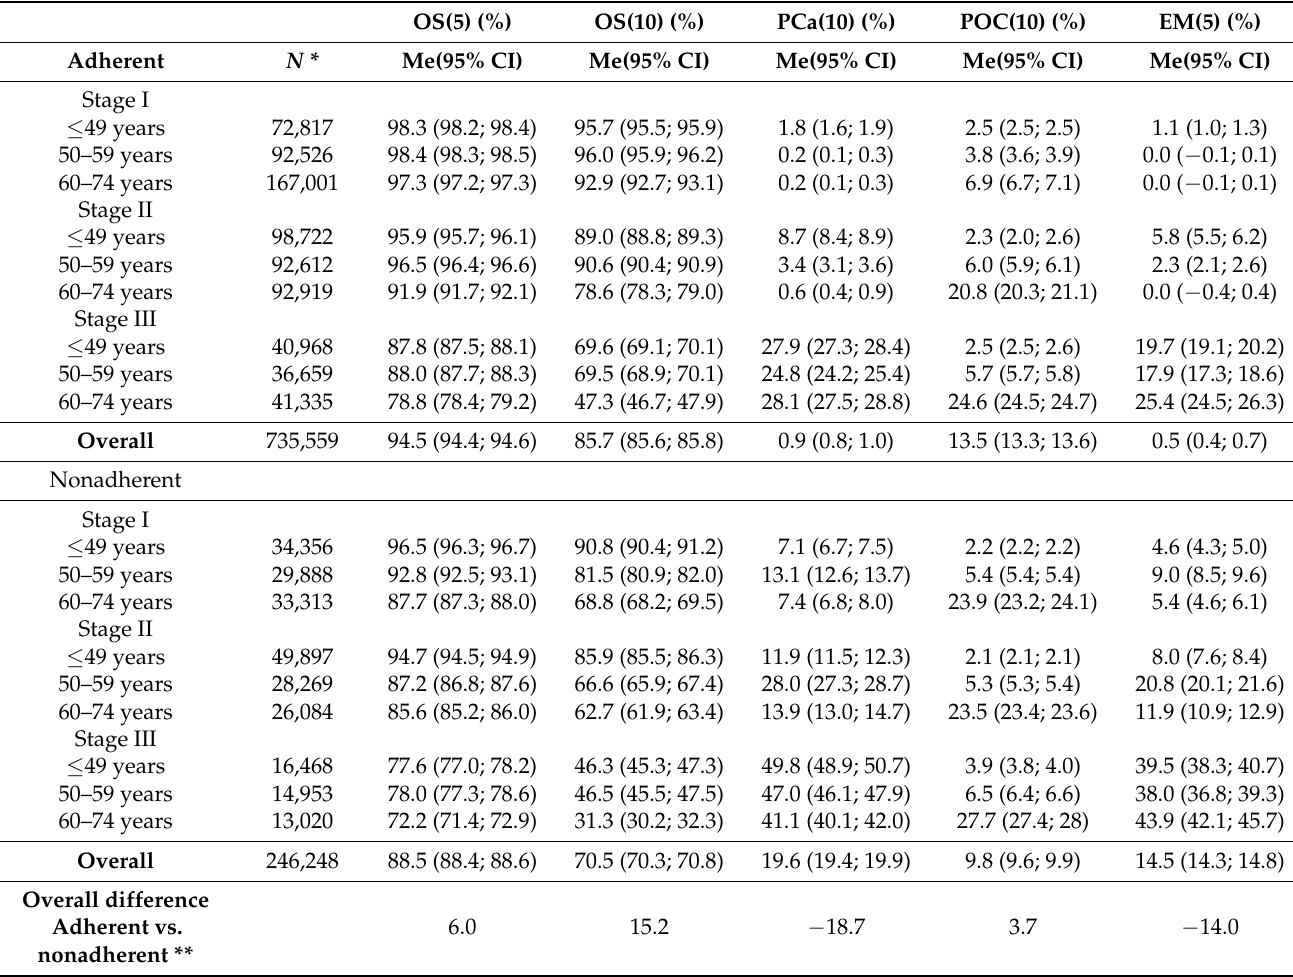
Table 3. Survival indicators derived from synthetic cohort comparing breast cancer patients adherent vs. nonadherent to endocrine therapy across age groups and stage at